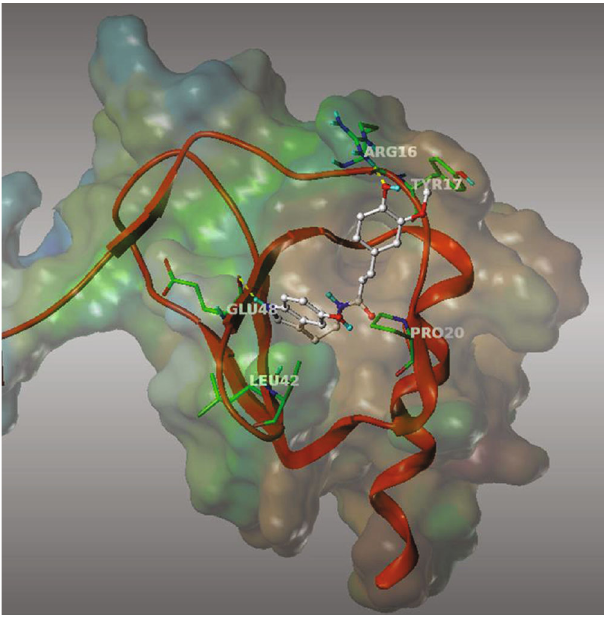
Figure 1: 3D representation of the binding of N -feruloylserotonin to the chemokine